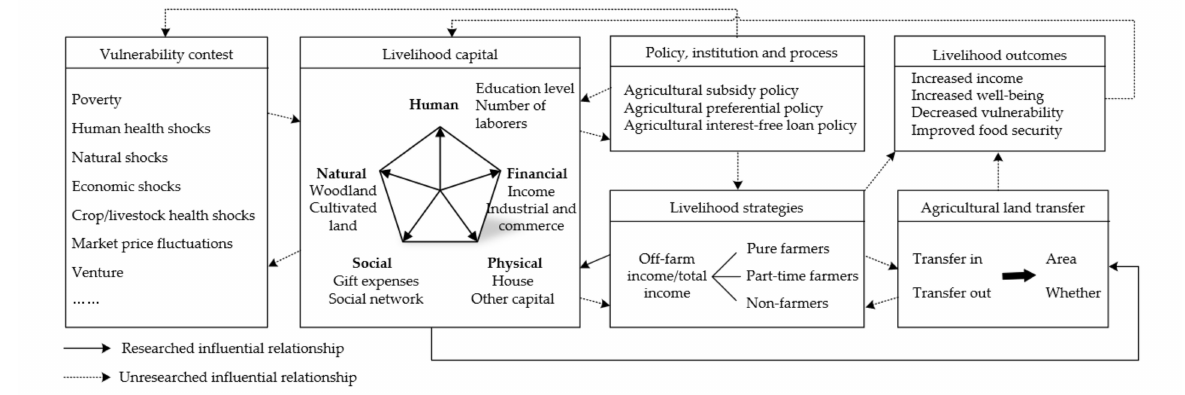
Figure 1. Analysis frame diagram of household livelihood capital and land